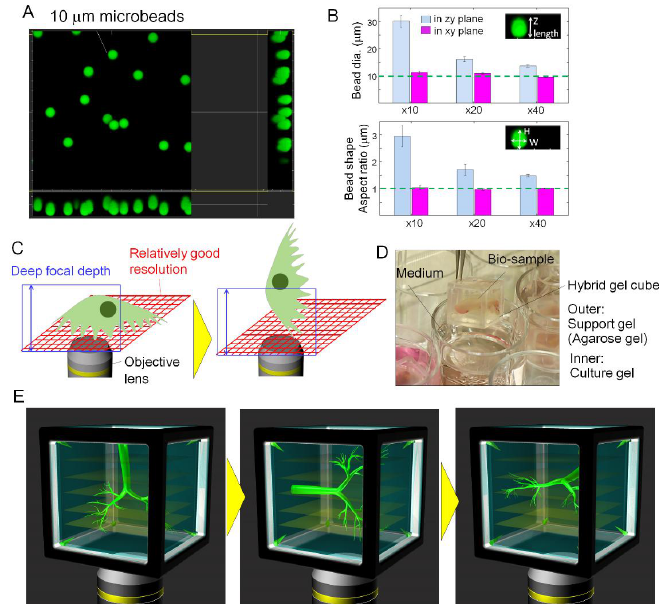
Figure 1. Large-scale tissue imaging concept. ( A ) 3D image taken by a confocal microscope with a 40 × objective lens. The projected image of microbeads 10 µm in diameter to the y-z and z-x planes was elongated due to the focal depth. ( B ) Quantitative evaluation of the relationship between magnification of objective lens and measurement errors in dimension and shape. Using a 10× magnification lens, the measurement error for both dimension and shape was 300% in both the y-z and z-x planes, but was considerably smaller in the x-y plane. ( C ) Conceptual diagram showing a method to improve resolution in the z -direction. Deep focal depth with a low magnification lens results in a deterioration of spatial resolution. However, sample rotation after z -stack imaging could convert poor z -resolution to rich x-y resolution. ( D ) Representative image of a gel cube device. The agarose walls were sufficiently rigid to maintain extracellular matrix (ECM) and a bio-sample inside, while being sufficiently permeable to allow high molecular weight nutrients to pass into the device from the culture medium. Thus, a bio-sample can be cultured by immersing the device in culture medium and by picking up and rotating the cubic device containing ECM during culturing. ( E ) Conceptual image of large-scale imaging with a low magnification lens by the gel cube device. Rotating the sample by 90 degrees allowed multiple scanning in six directions, resulting in high-resolution imaging of millimeter-sized